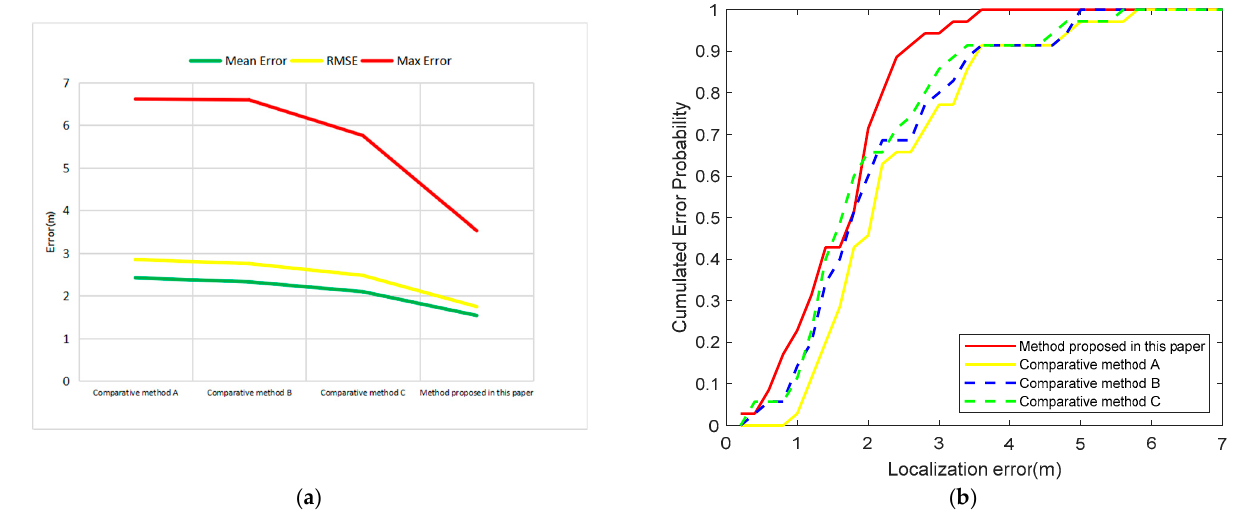
Figure 12. Error comparison discussion, ( a ) Error improvement; ( b ) Cumulative distribution functions of the localization error for the four methods.